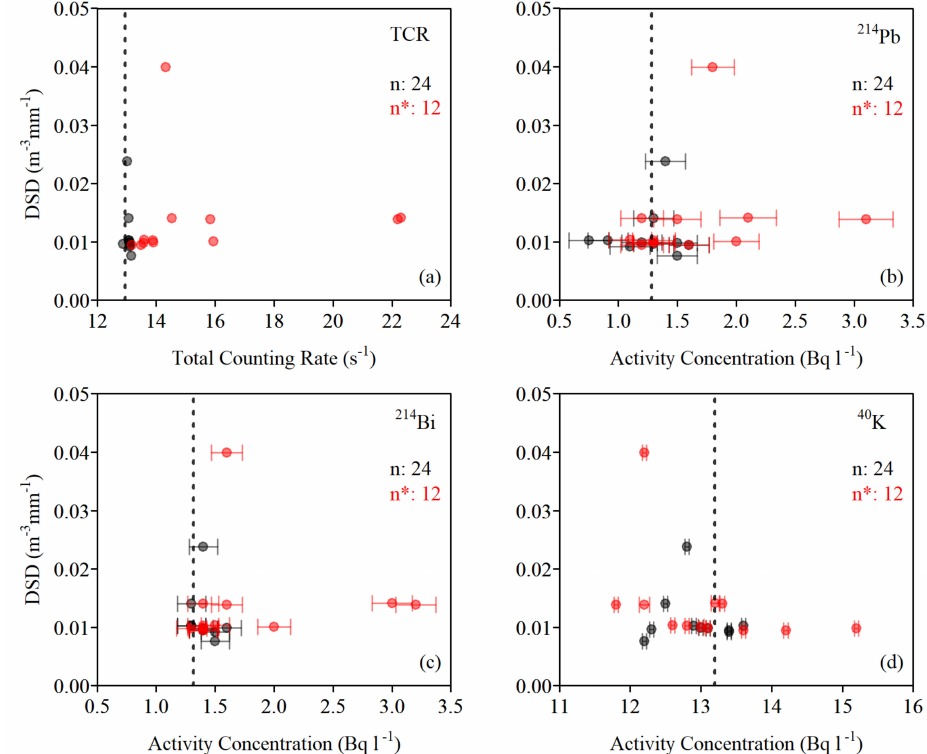
Figure A6. Drop size distribution of small size class (0.8–1.2 mm) over TCR ( a ), 214 Pb ( b ), 214 Bi ( c ) and 40 K ( d ). The total number of events is n = 24. The events of statistically significant variation of TCR ( n * = 12) are presented with red